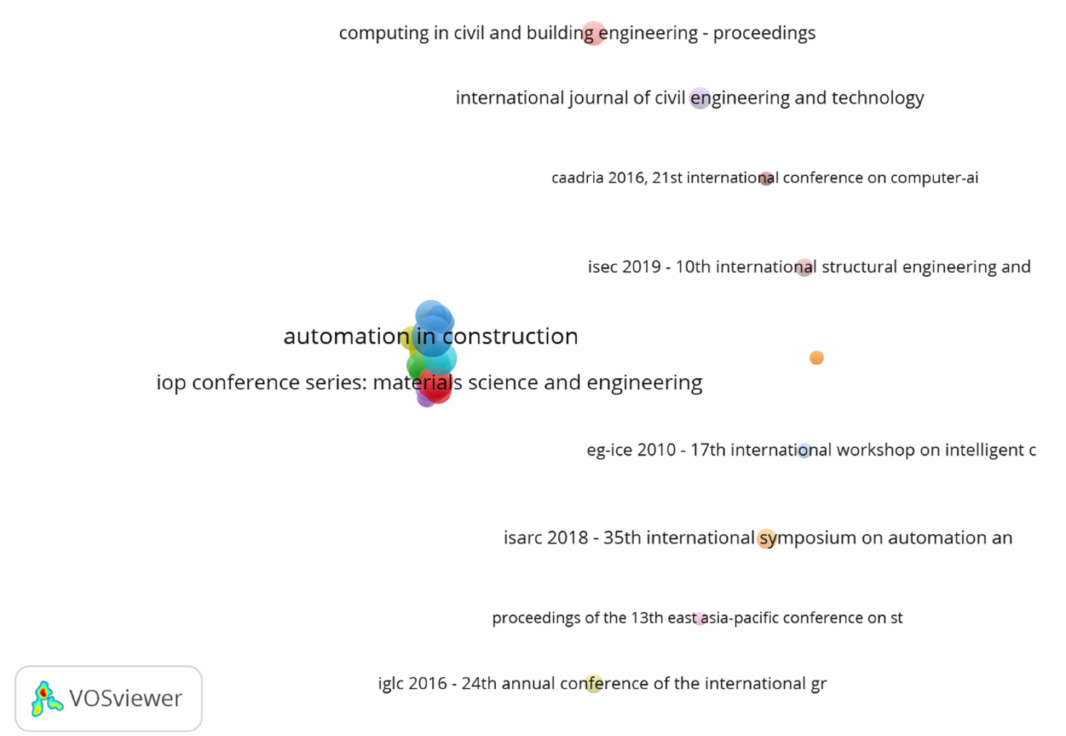
Figure 9. Publication